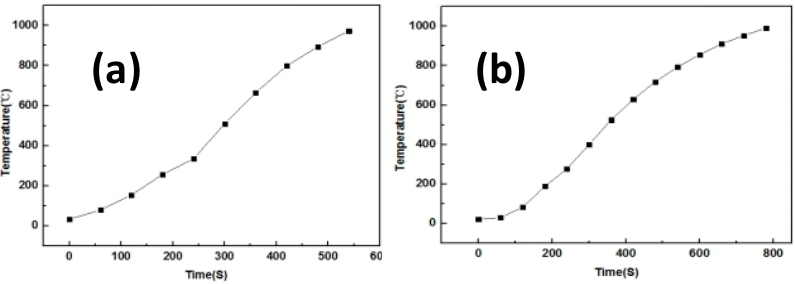
Figure 5. Temperature rise characteristic curves in the microwave field of chromite ( a ) and Na 2 CO 3 ( b ).